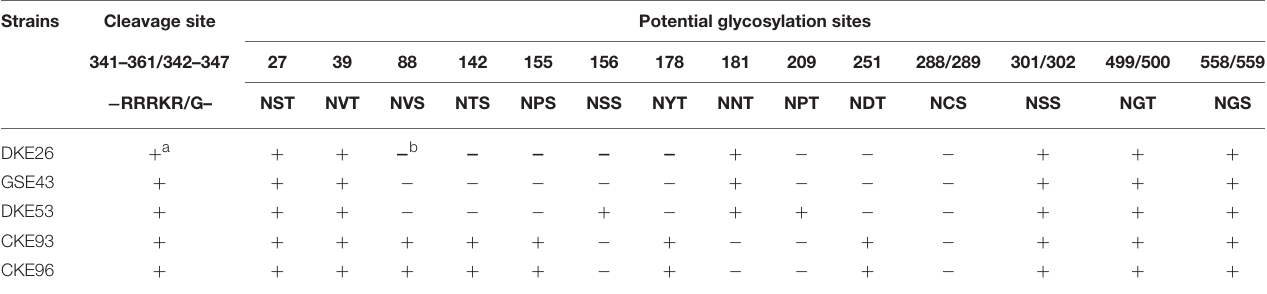
TABLE 2 | Cleavage site and potential glycosylation sites in HA of the five H5N1 HPAIVs.